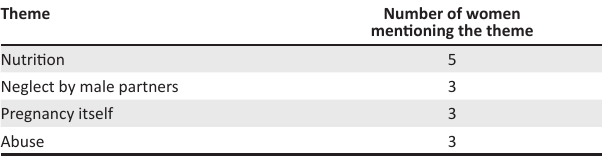
TABLE 3: Themes and categories generated from the study.